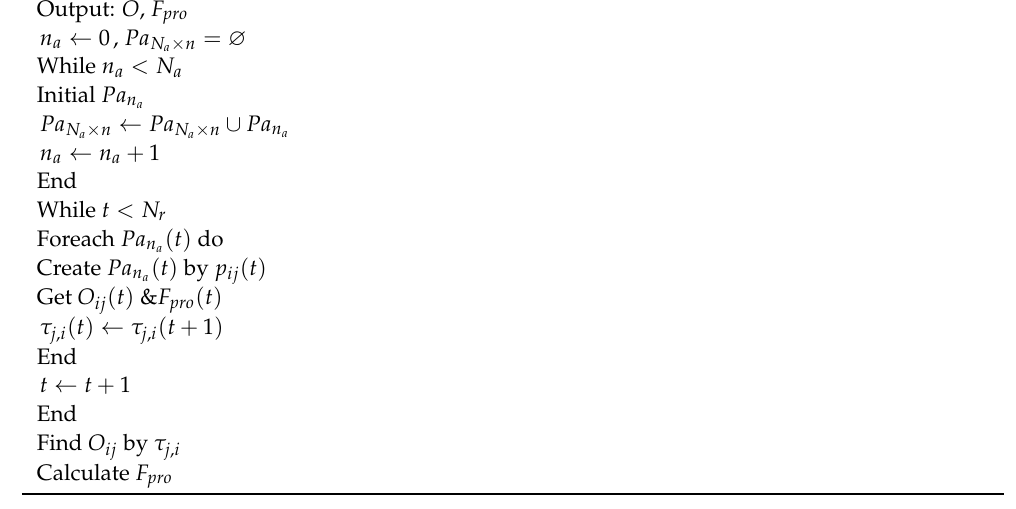
Algorithm 2: ACO for the Placement Scheme